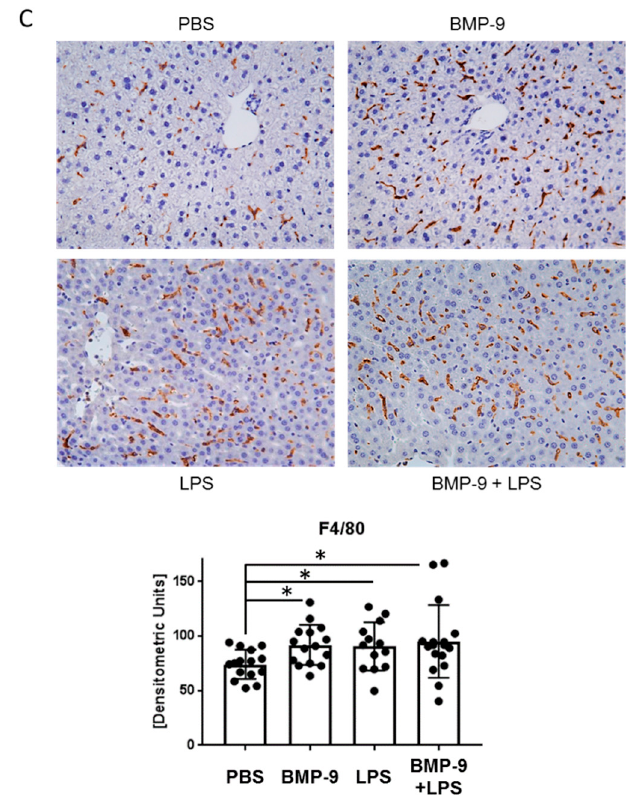
Figure 6. Injection of BMP-9 / LPS into mice results in enhanced LPS-mediated induction of pro-inflammatory targets. ( A ) RNA samples were prepared from the livers of mice (C57BL / 6; n = 5 per group) 2 h and 12 h after injections of PBS (control), BMP-9 (100 ng / mouse), LPS (25 µ g / mouse) or a mixture of both and expression levels of IL-10, IL-6, IL-1 β and TNF α were determined by RT-qPCR. Data are expressed as average values ± SD ( ∆ Ct of target gene versus house-keeping gene (Ppia)); ( B ) Liver tissue was processed for ELISA measurements of protein levels of IL-6, IL-1 β and IL-10; ( C ) Immunohistochemistry was performed to analyse the amount of F4 / 80-positive cells (only 12 h time-point). Representative staining examples are shown in the upper part (200-fold magnification) and quantification of the staining intensities is shown below. p < 0.05 was considered statistically significant (*). ** indicates p < 0.01. Each dot in ( A ) and ( B ) represents the average value of samples from the livers of an individual mouse. Dots in ( C ) represent densitometric values of individual image sections.